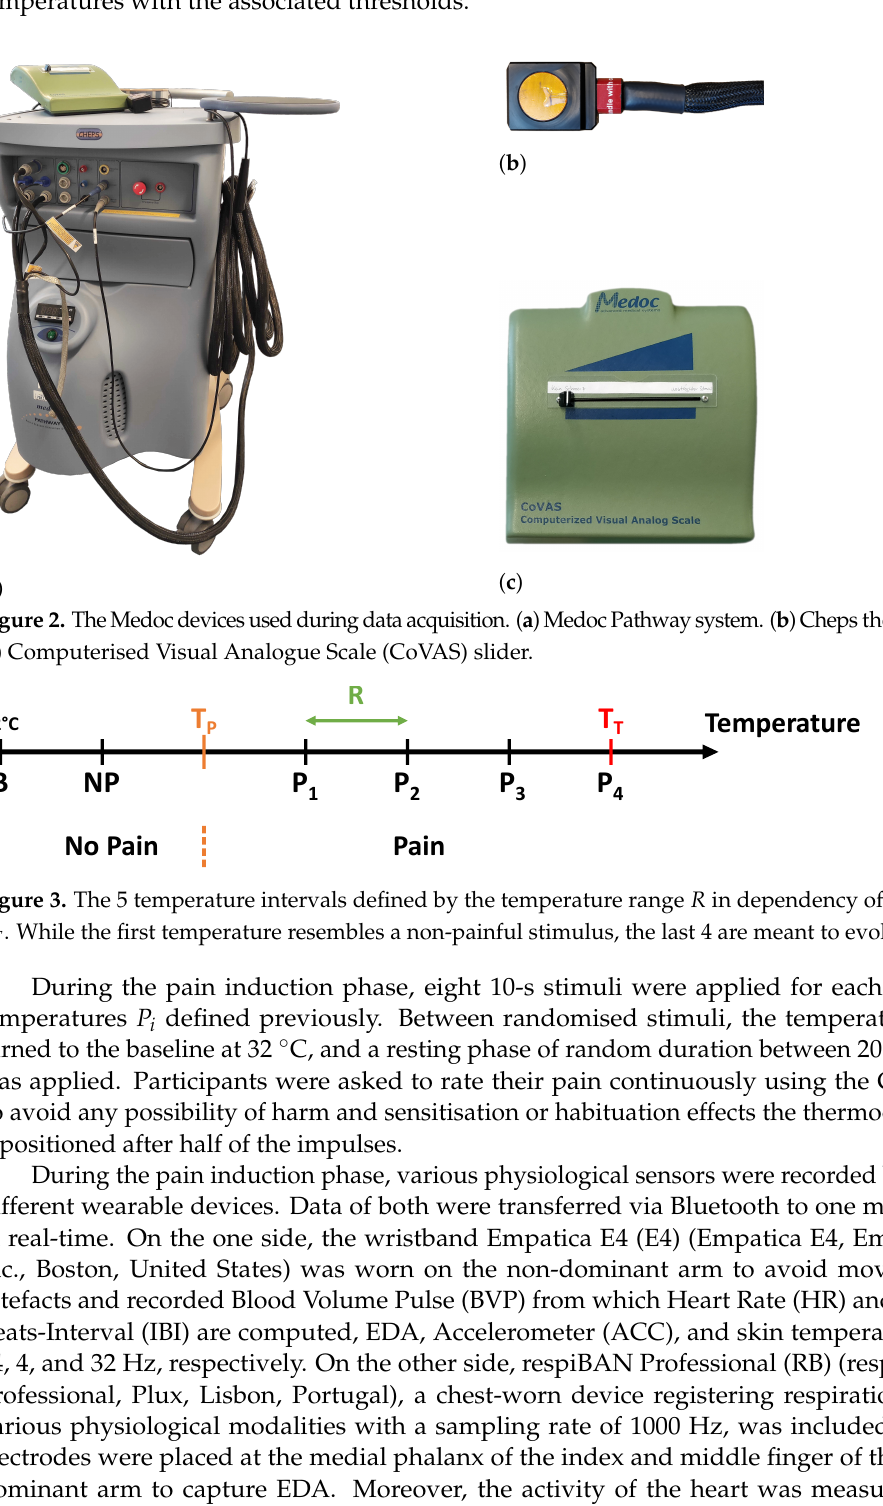
was applied. Participants were asked to rate their pain continuously using the